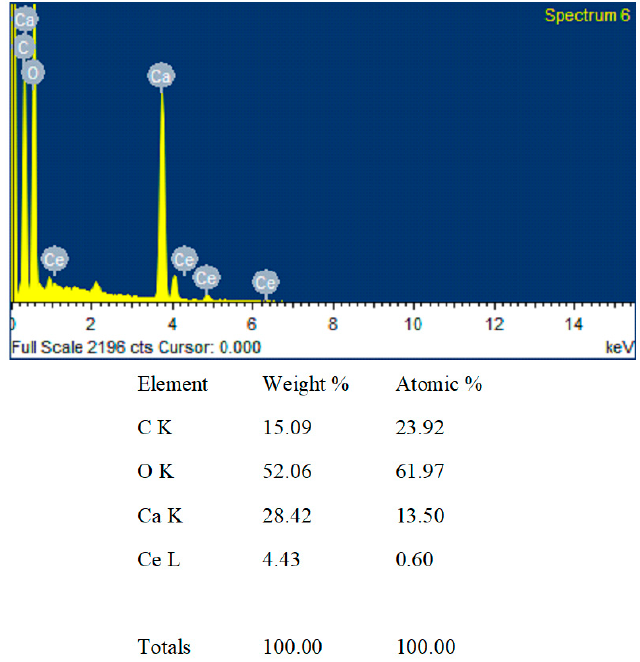
Figure 4. Spectra and chemical composition chart of CaCO 3 :Ce particles. Figure 4. spectra and chemical composition chart of CaCO Figure 4. spectra and chemical composition chart of CaCO 3 :Ce particles.